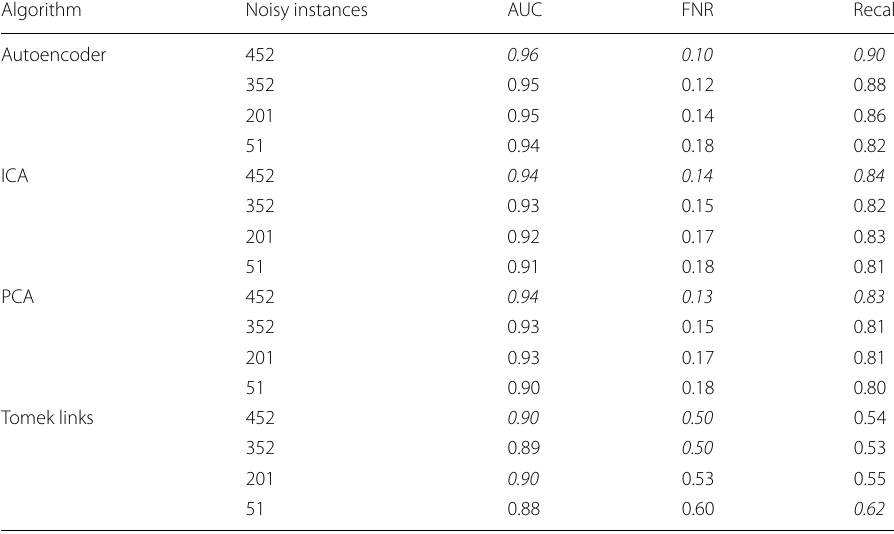
Table 2 Label noise detection results Algorithm